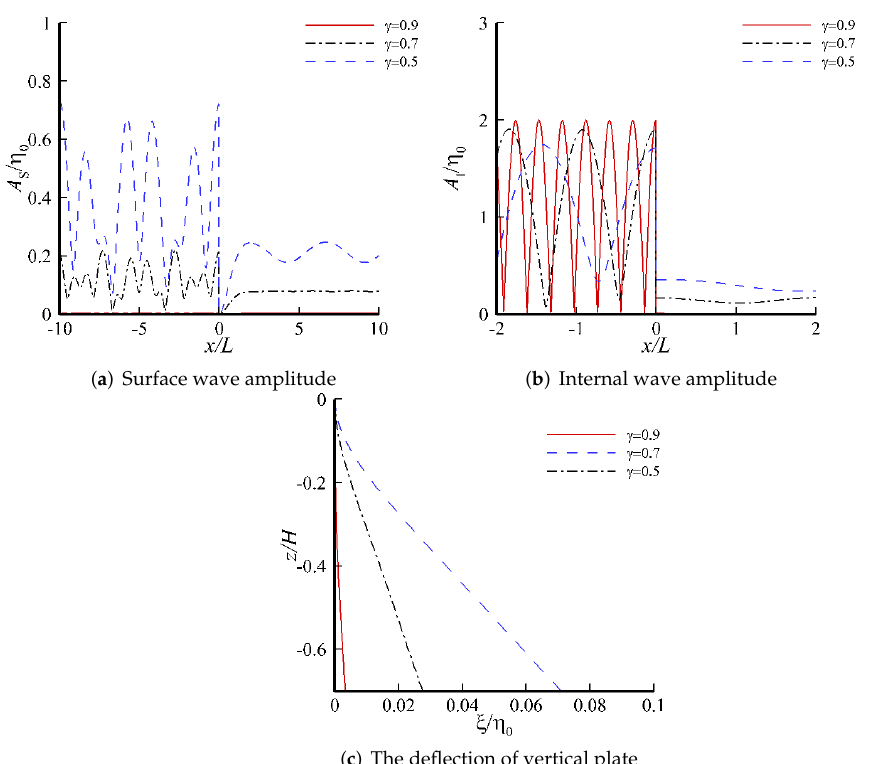
Figure 16. Wave amplitudes A S ( x ) , A I ( x ) and deflection of vertical plate ξ ( z ) for the different density ratio γ in the case of the incident waves of the interfacial wave mode.